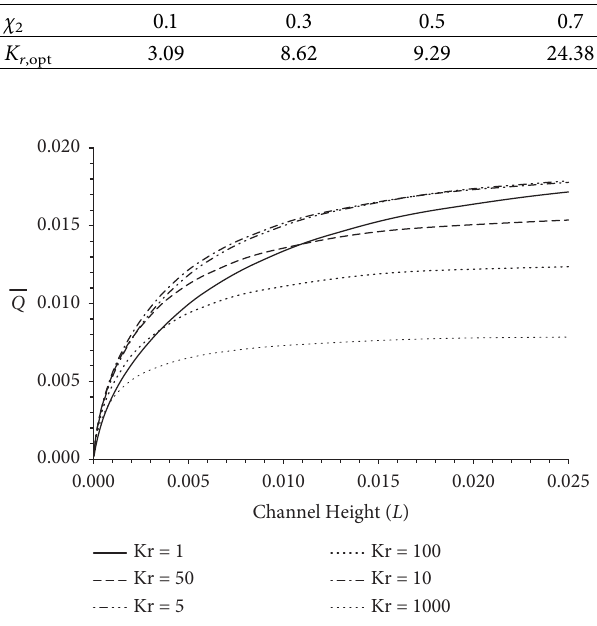
Figure 9: Total heat absorbed versus channel height for different K r , E � 0.5, χ 2 � 0.5, δ o � 0.2, δ i � 0.1 for case